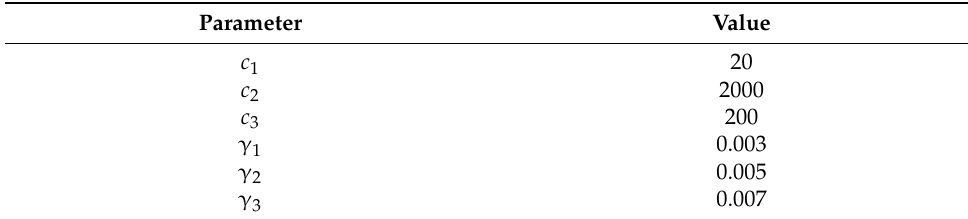
Table 7. The design control